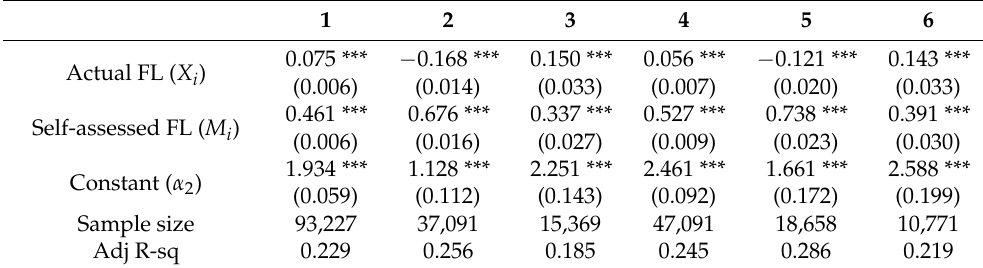
Table 3. Factors that determine risk preference (regression results for Equation